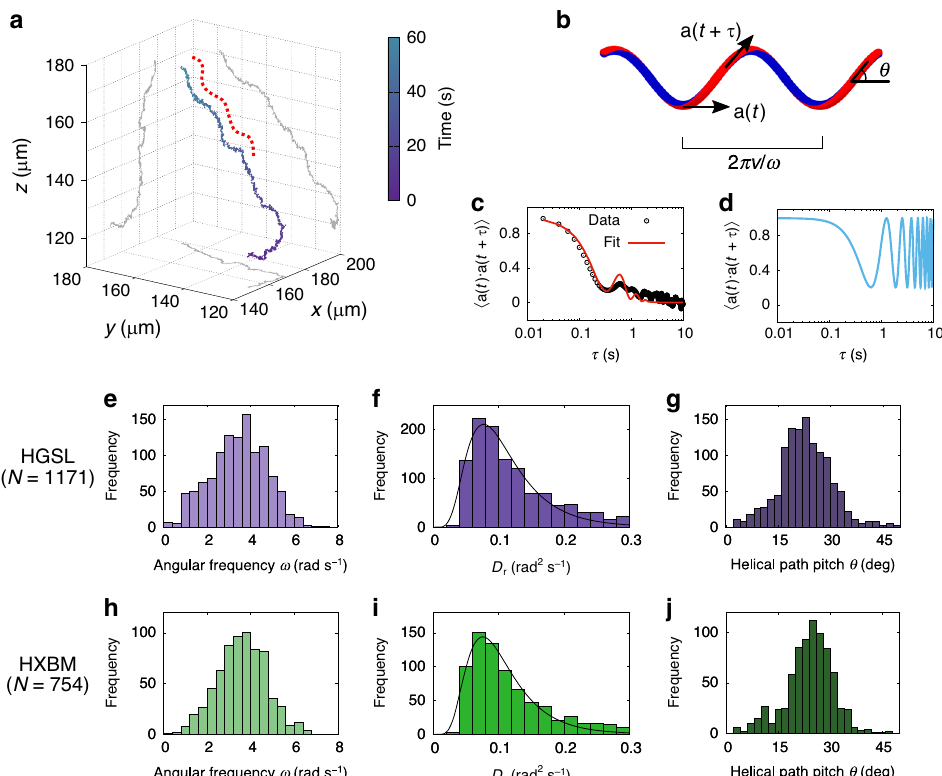
Fig. 3 Model-based extraction of transport parameters. a An exemplar trajectory of Haloferax sp. Boulby Mine (HXBM), showing helical tendency. The red dashed line is a guide to the eye showing left-handed helix shape, grey lines are planar projections of the track. b Idealised helical track showing the parameters in our model: tangent vector ( a ), pitch ( θ ), and angular frequency ( ω ). c Angular correlation function a ð t Þ (cid:2) a ð t þ τ Þ Haloarcula sp. Great Salt Lake (HGSL). The analytical fi t (solid line), shows damped oscillatory behaviour imposed on an exponential decay. d Angular correlation of the idealised helix, e.g., in panel b , with no rotational Brownian motion. e – g Distributions of ω , D r (including log-normal fi t), and θ of HGSL ( N = 1171 tracks), extracted from three-dimensional tracks. h – j The same parameters for